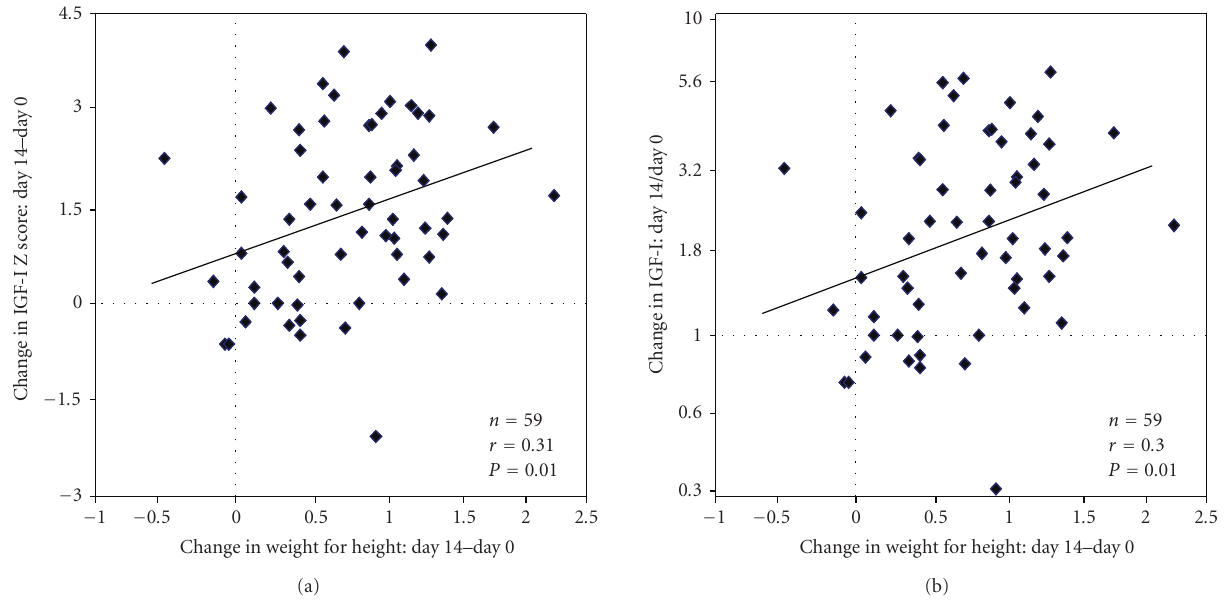
Figure 3: Relationship between the change in IGF-I expressed as an increase in Z-score (a) or as a ratio in absolute measurements (b) and the change in age- and sex-adjusted weight for height Z-score using Burkina Faso data as references, after 14 days of nutritional rehabilitation.